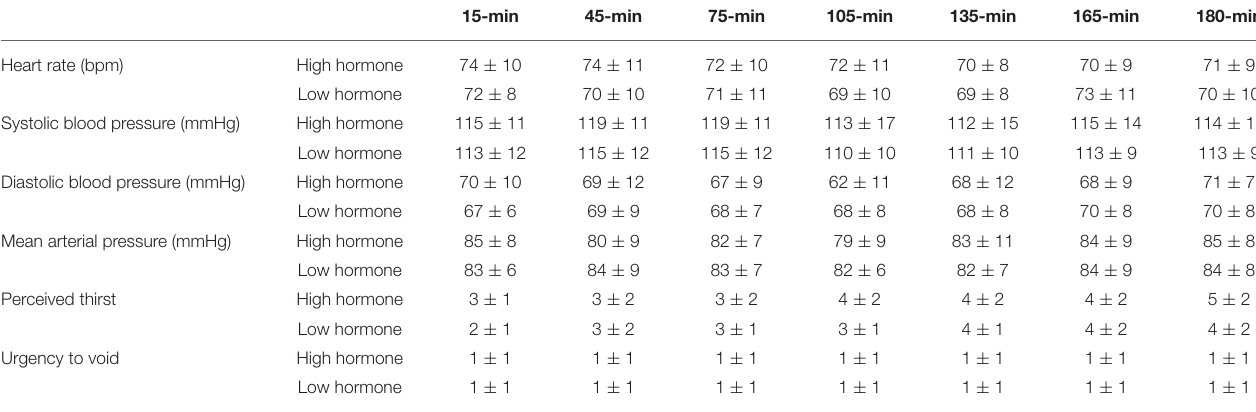
TABLE 3 | 3-h repeated